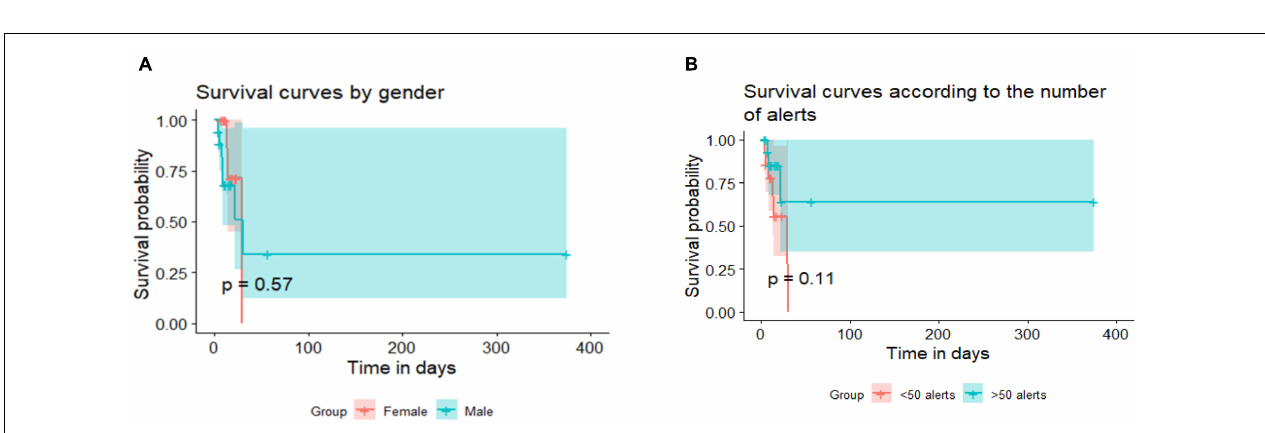
FIGURE 2 | Survival analysis. (A) Survival curves by gender. (B) Survival curves by number of alerts. Copyright: Predimed Technology, Schiltigheim, France.